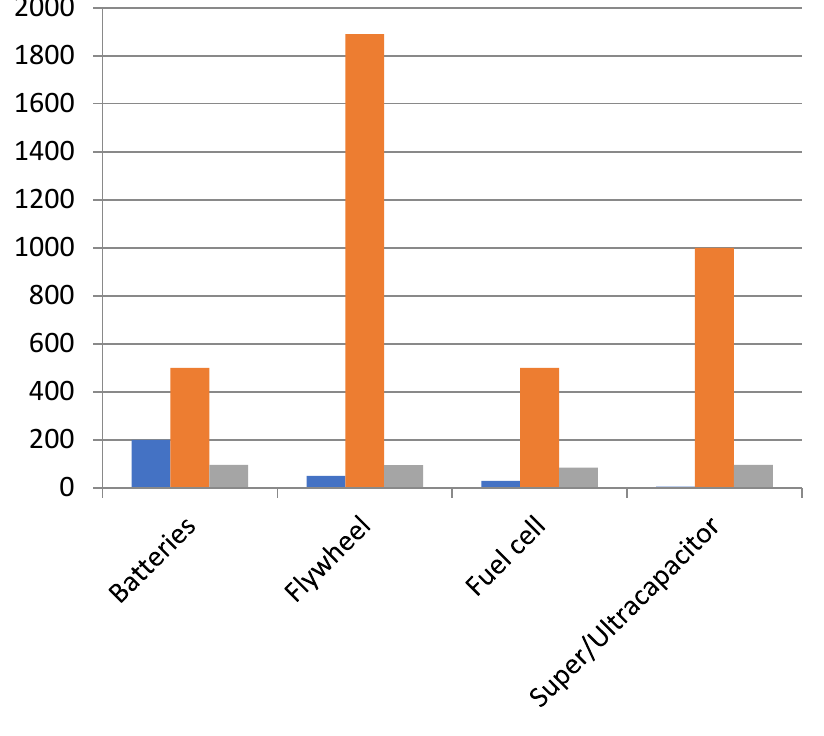
Figure 7. Performance comparison of various ESSs.